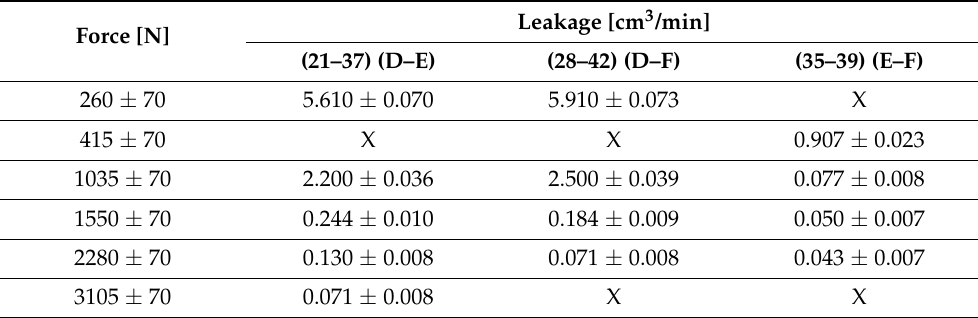
Table 10. Forces and leakage for a pair of samples with surface topography parameters from code groups D, E, and